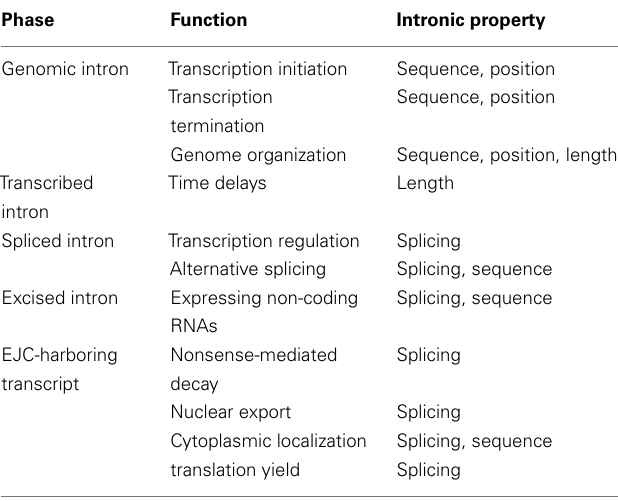
Table 1 | Summary of the intronic functions covered in this